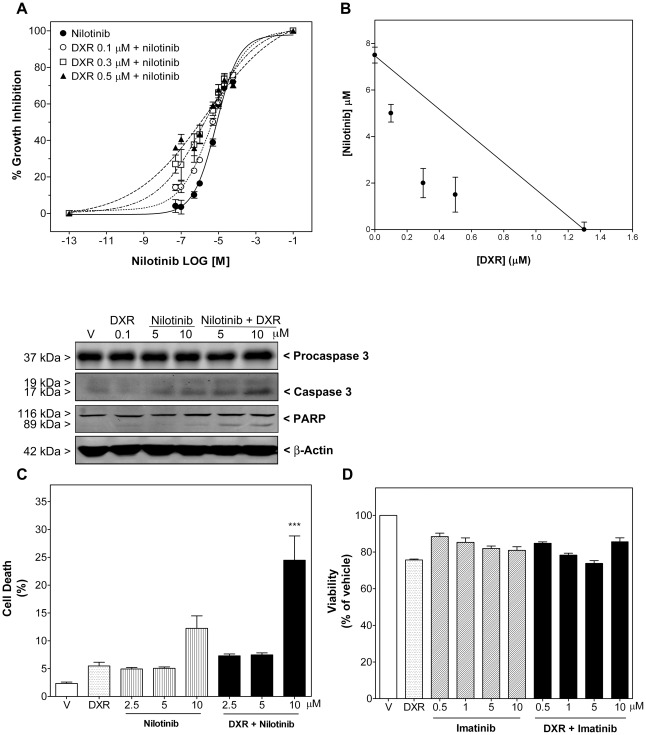
Combination of nilotinib, but not imatinib, with doxorubicin (DXR) displayed a synergistic effect on growth inhibition and apoptosis in synovial sarcoma SW982 cells.A) Antiproliferative effect of nilotinib as single compound or combined with DXR. Synovial sarcoma cells were treated with vehicle or nilotinib (0.1–40 µM) alone or combined simultaneously with DXR (0.1, 0.3 and 0.5 µM) for 72 h. Each value represents mean ± SEM of four individual experiments performed in triplicate. B) Subsequent isobolographic analyses were performed as described in the Material and Methods section. Drug combination was synergistic at all concentrations (CI<1), as shown in the isobologram. C) Apoptotic effect of nilotinib as single compound or combined with DXR (0.1 µM) for 72 h. Upper panels show the immunoreactive bands of procaspase 3, cleaved caspase 3 and PARP fragmentation in representative immunoblots. DNA content of cells was measured by flow cytometry. Columns show percentage of apoptotic cells in the absence (vehicle, V) or presence of DXR and nilotinib as single compounds or combined (DXR+nilotinib). Each column represents mean ± SEM of four independent experiments. ***
P<0.001 versus DXR-treated cells. D) Antiproliferative effect of imatinib (0.5–10 µM) as single compound or combined with DXR (0.1 µM) for 72 h. Each column represents mean ± SEM of three independent experiments.